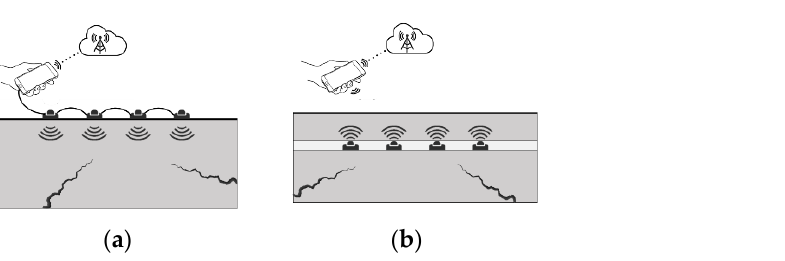
Figure 2. Implementation of monitoring sensors: ( a ) surface sensors and ( b ) embedded sensors.